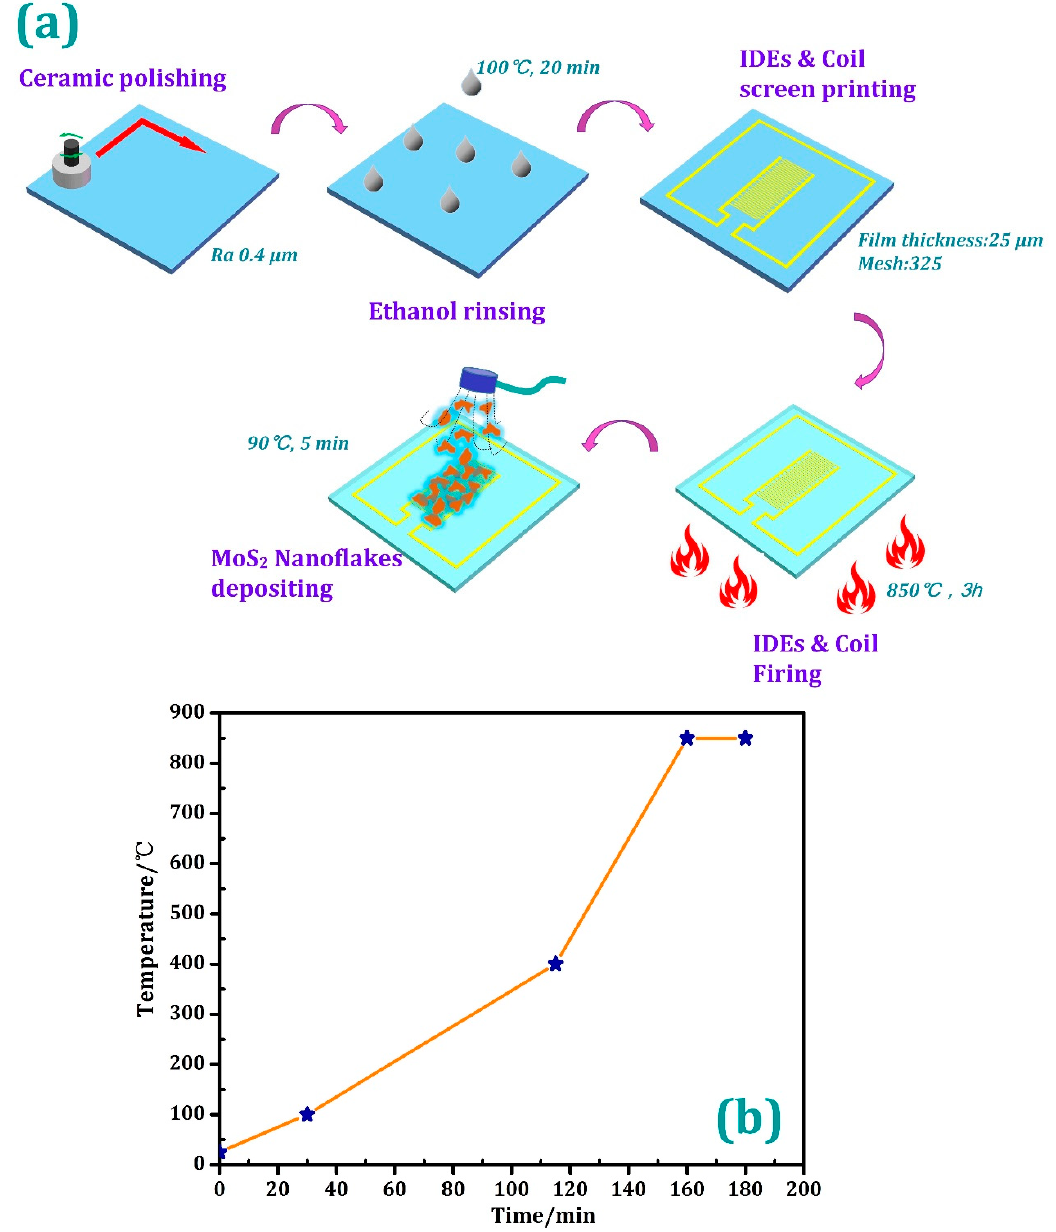
Figure 2. ( a ) The fabrication process and ( b ) the firing curve of the as-prepared LC humidity